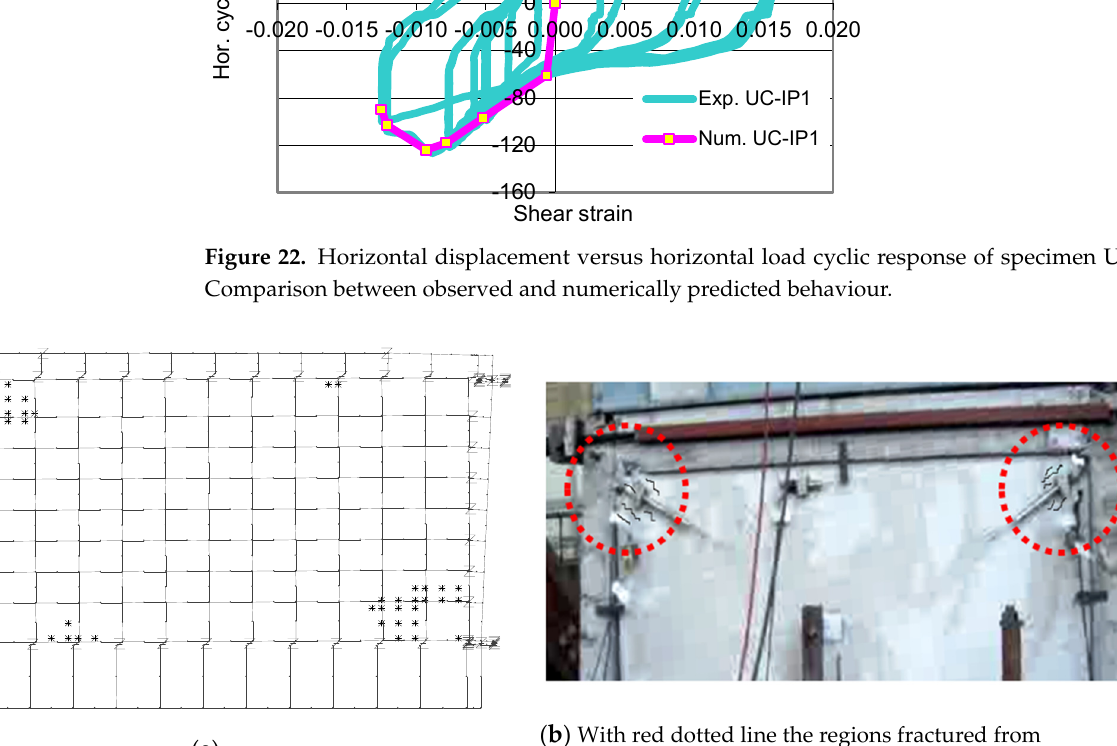
Figure 23. ( a ) The numerically predicted compression limit state for specimen UC-IP 1. ( b ) The observed damage for specimen UC-IP 1.